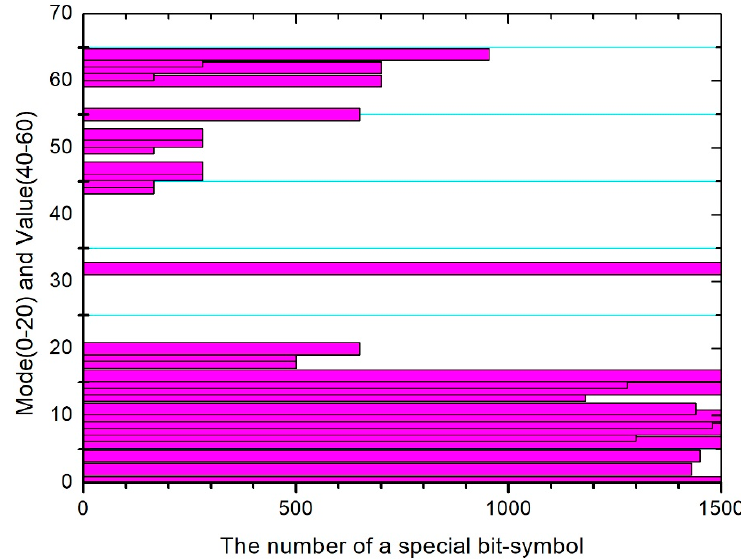
Figure 5. The number of a special bit-symbol in the data field of 8 bytes.